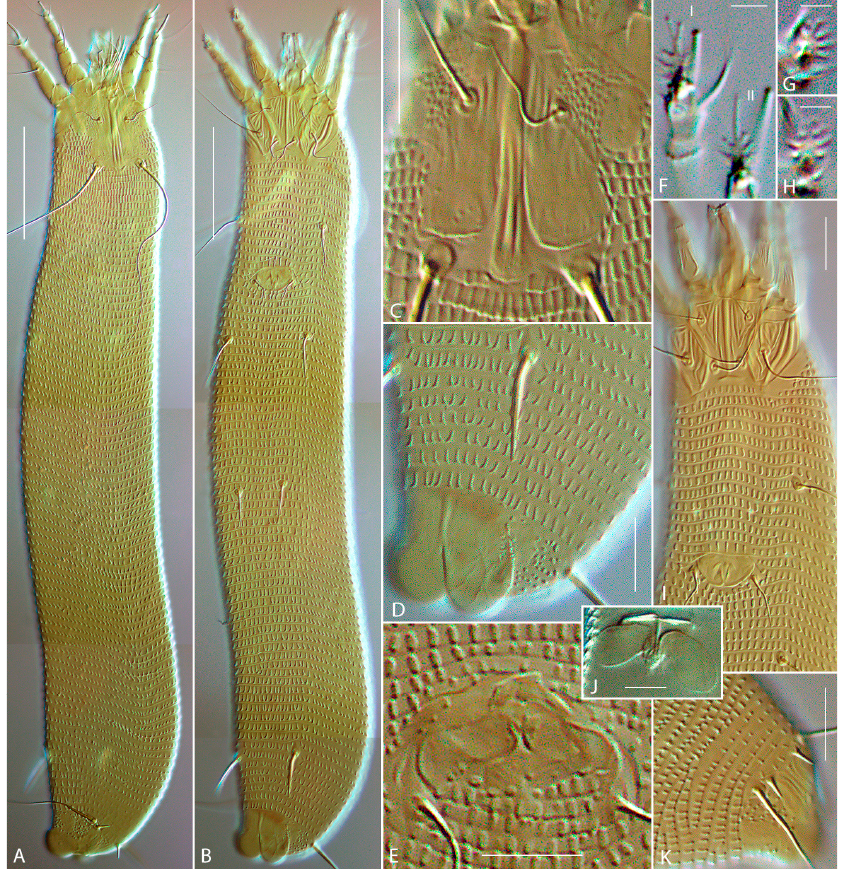
Figure 8. DIC LM images of Novophytoptus limpopoensis n. sp. ( A , B )—dorsal ( A ) and ventral ( B ) view